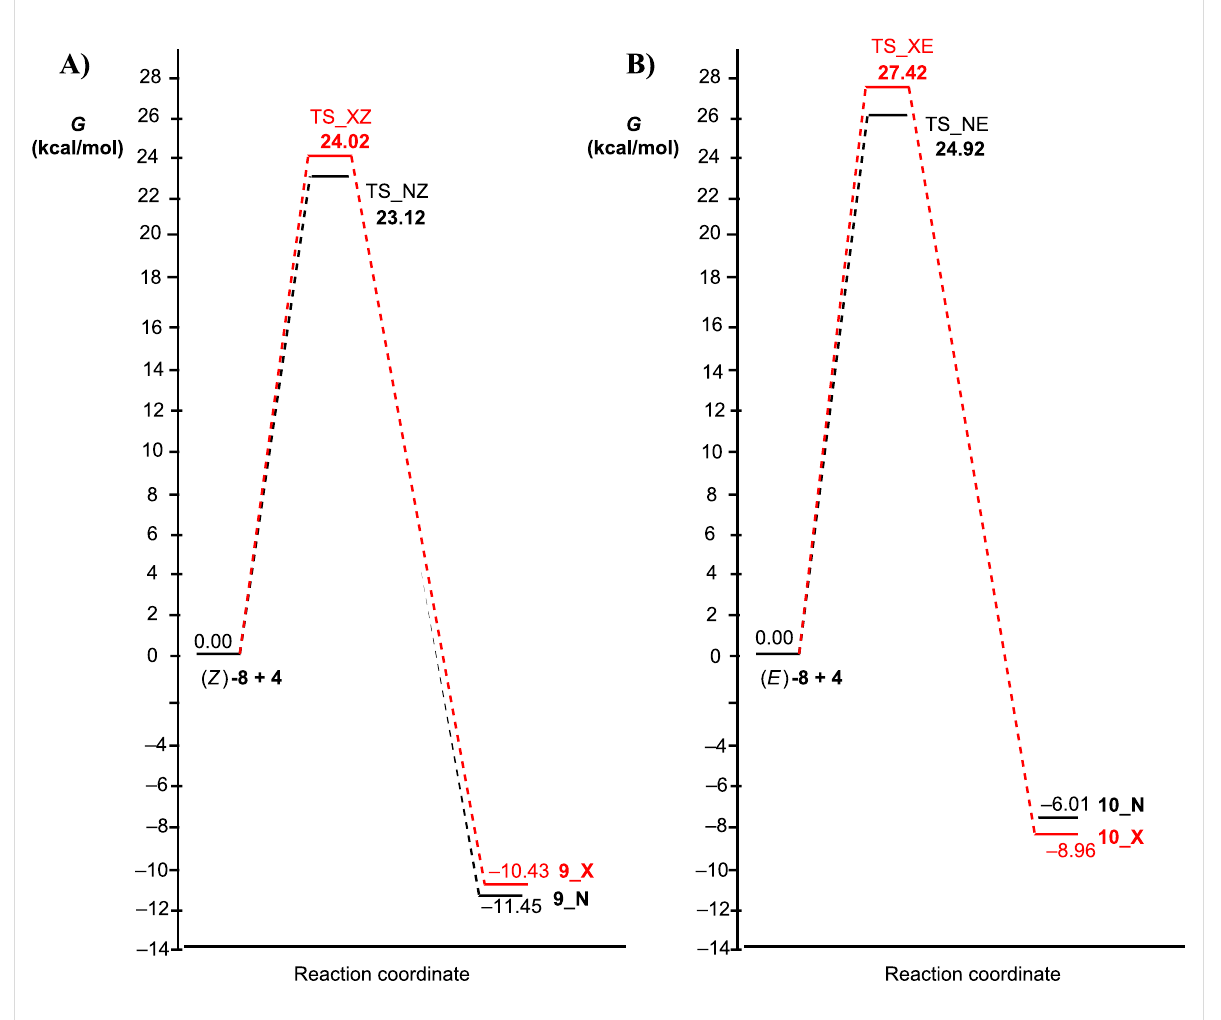
Figure 6: Free energy profiles for the cycloaddition reaction of the two isomers Z (A) or E (B) of dipolarophile 8 with nitrone 4 , considering both the endo (N, black) or exo (X, red) path.